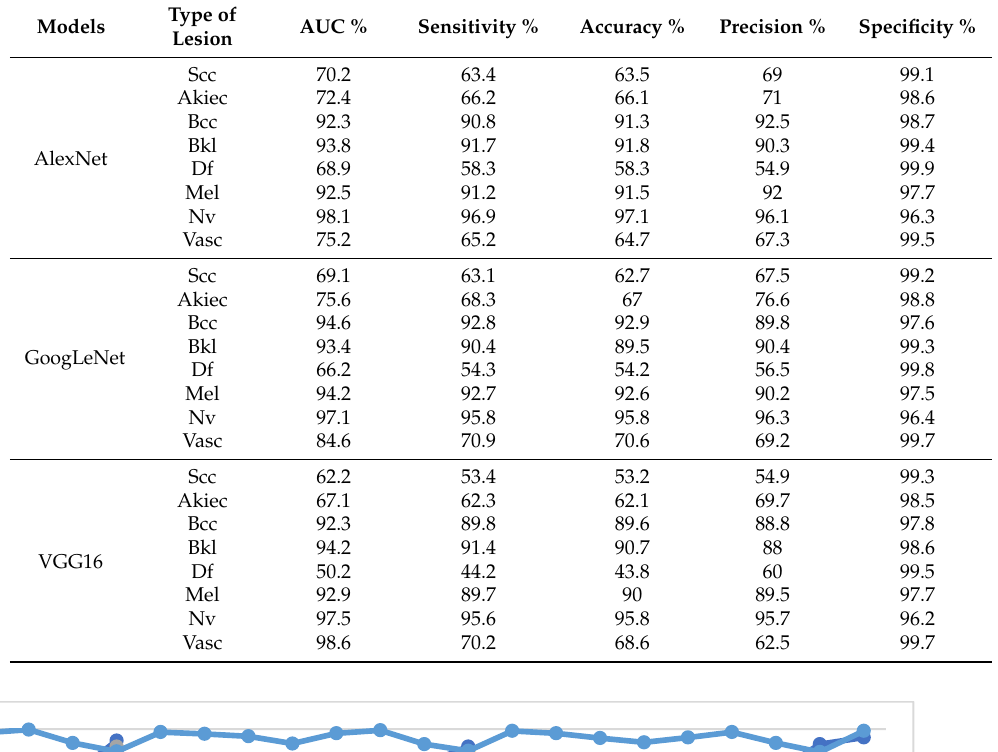
Table 4. Performance results of pre-trained CNN models based on ROI using GAC method for early diagnosis and differentiation of skin cancer and other skin lesions.